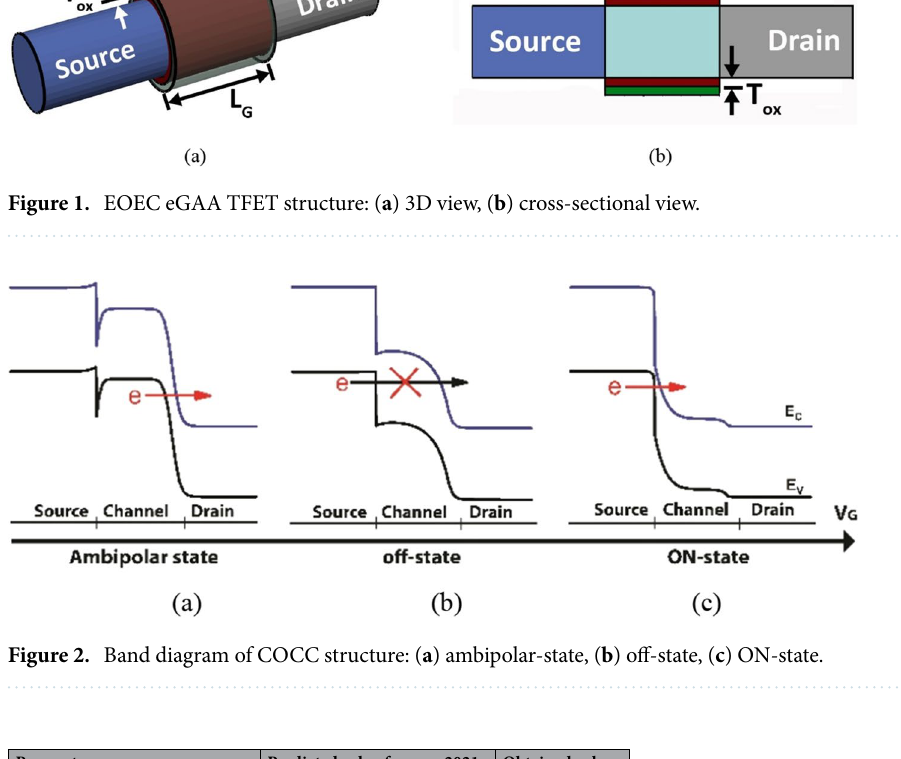
Parameter Predicted value for year 2021 Obtained